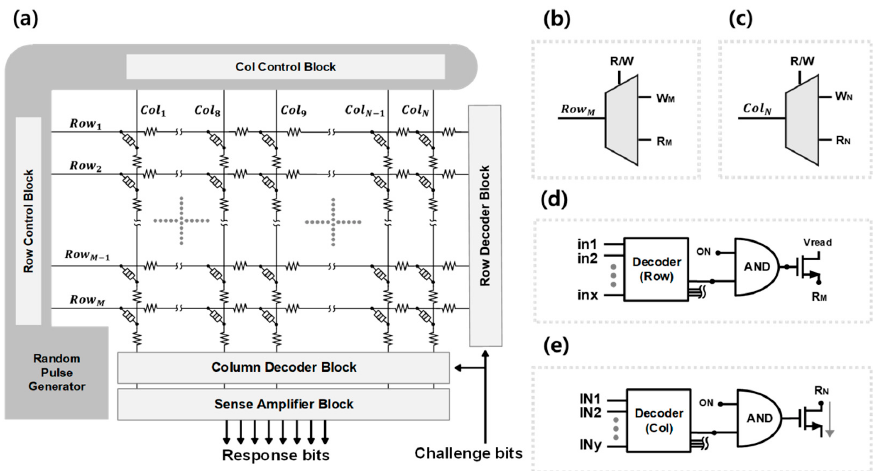
Figure 4. ( a ) Simplified pm ‐ PUF architecture; ( b ) row control circuitry; ( c ) column control circuitry; ( d ) row decoder circuitry; and ( e ) column decoder circuitry.